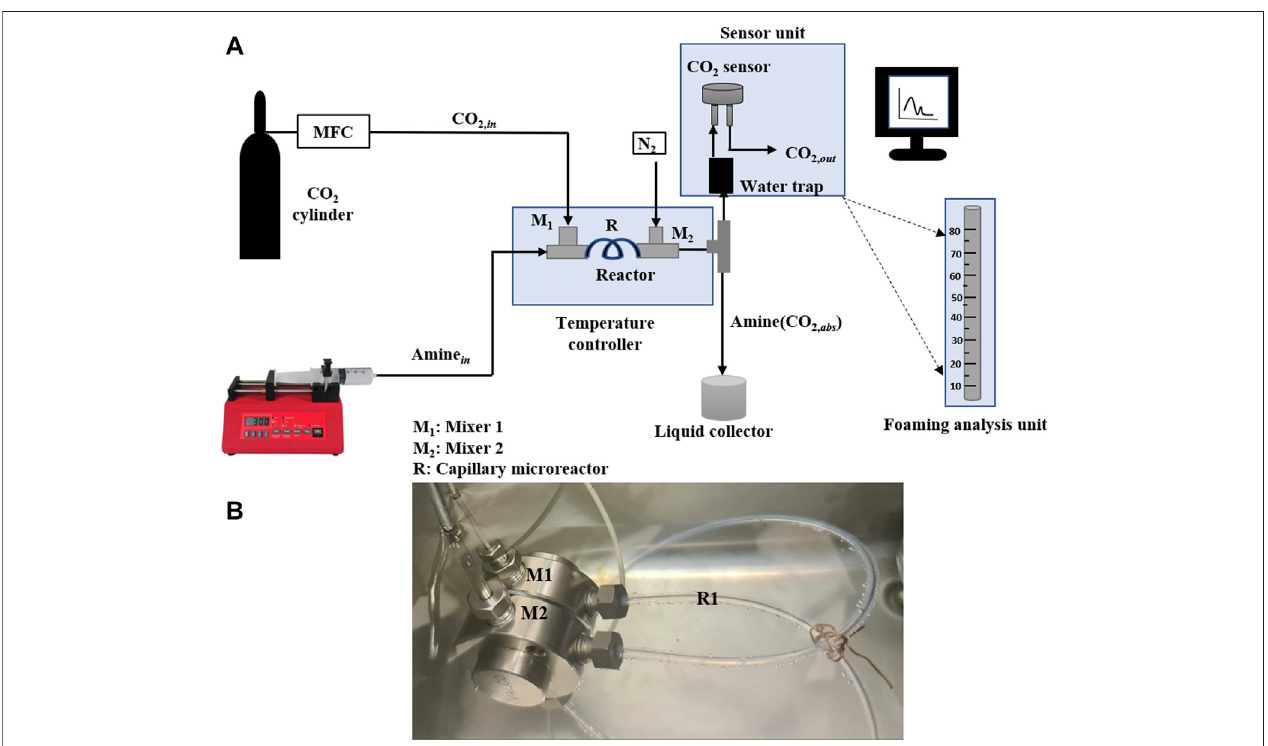
FIGURE2|(A) Schematicdiagramoftheexperimentalset-upforCO 2 absorption-desorptionsystem (B) imageofthemixer-microcapillaryunitinthetemperature- controlled bath.